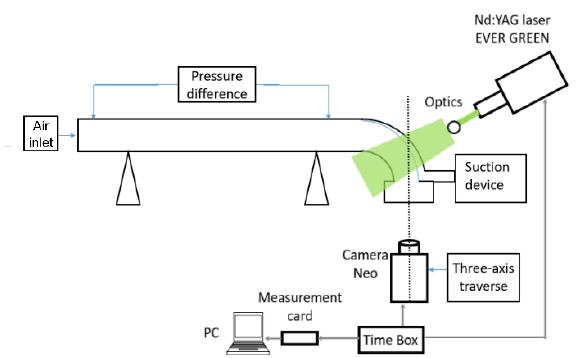
Fig. 1. Experimental setup for PIV measurements